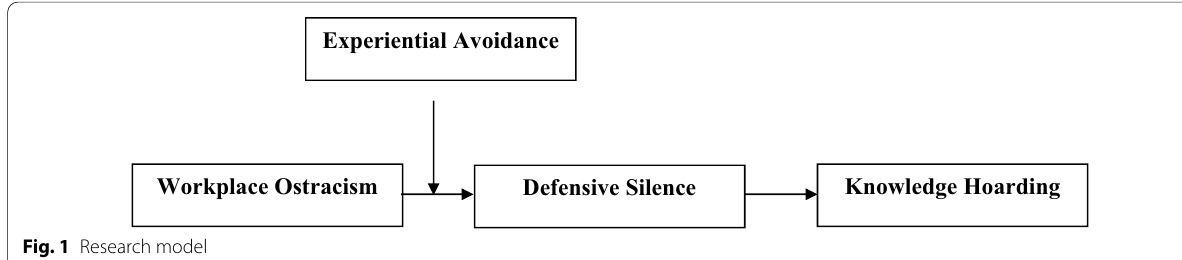
Table 2 Descriptive statistics and correlation coefficients of variables